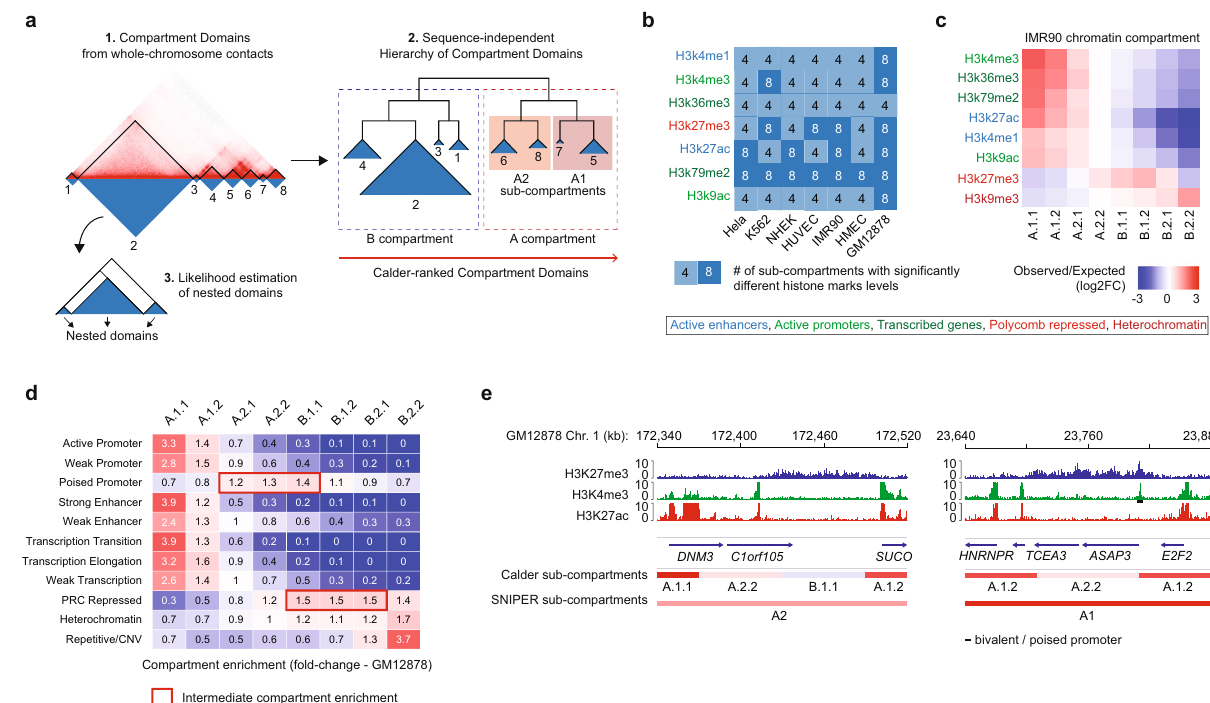
Fig. 1 Inference and characterization of chromatin subcompartments using Calder. a Main steps of Calder: Step 1) identifying compartment domains from whole-chromosome contacts (top left); Step 2) deriving sequence-independent hierarchy of compartment domains (right); Step 3) fi nding nested domains from short-range contacts (bottom left). b Maximum number of subcompartments among which signi fi cant differences between mean ChiP-seq intensities of the domains were found for different histone marks (rows) and cell lines (columns). c Enrichment of histone marks (rows) in each subcompartment (columns) of IMR90 cell line. Log 2 fold-changes between the median value within a compartment and the expected median value is color coded. Histone modi fi cation names are color coded based on the regulatory element they mark. d Enrichment of ChromHMM states (rows) in each subcompartment (columns) for GM12878. Ratios between the distribution of compartment labels for each ChromHMM state and their expected distribution is color coded and reported. e Representative examples of subcompartments inferred by Calder and SNIPER (colored tracks at the bottom) in two regions of Chr.1. of the GM12878 cell line. ChIP-seq tracks for H3K27me3 (blue), H3K4me3 (green), and H3K27ac (red) are shown in these regions. The bivalent/poised promoter (marked by both H3K4me3 and H3K27me3) of the ASAP3 gene is